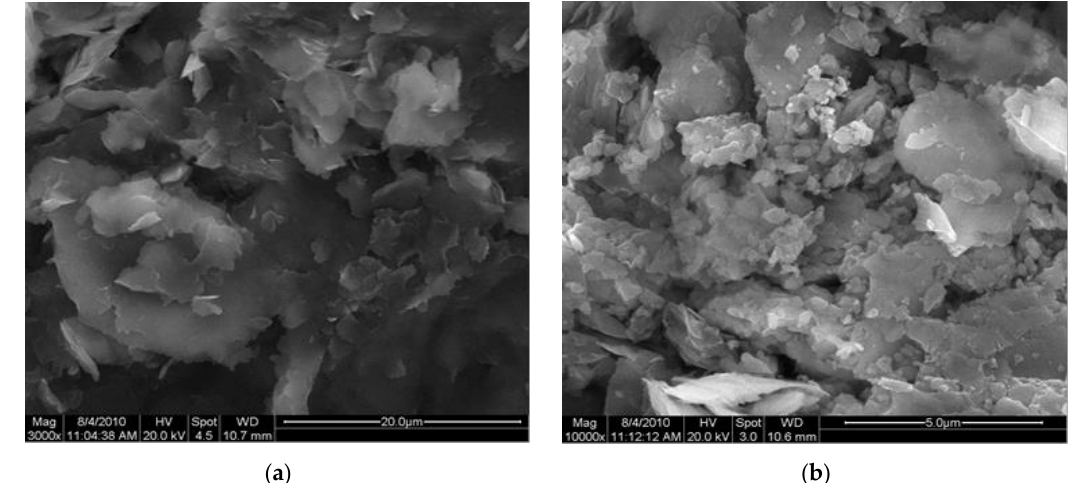
Figure 2. Scanning electron microscope image of rock sample: ( a ) magnified 3000 times; ( b ) magnified 10,000 times.